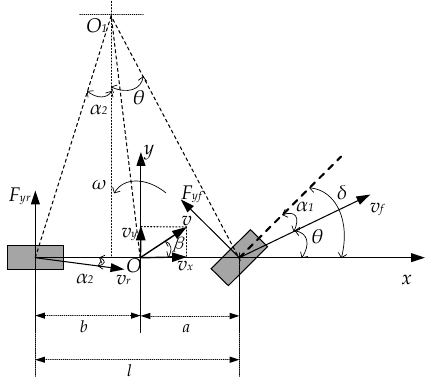
Figure 1. Two-degrees-of-freedom vehicle dynamics model.